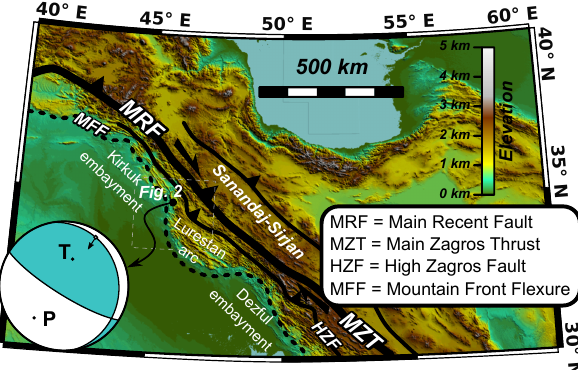
Figure 1. Tectonic sketch map of the Zagros Mountains, showing epicentre and moment tensor of the 12 November 2017 M w 7.3 earthquake (source: USGS, https://earthquake.usgs.gov/).